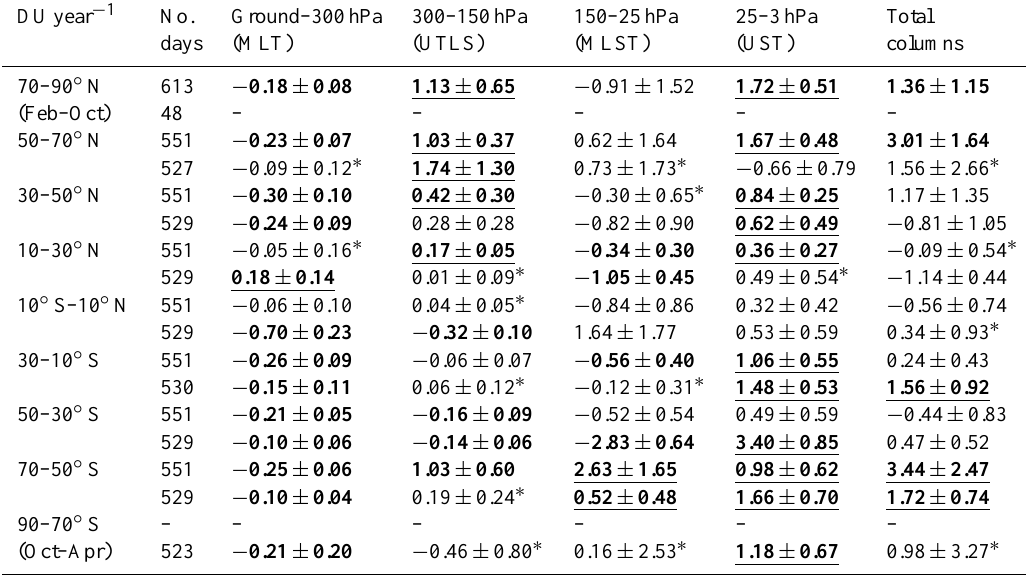
Table 3. Same as Table 2 but for seasonal O 3 trends and associated uncertainties based on daily medians during JJA (top values) and DJF (bottom values) periods. Values marked with a star (*) refer to trends which are rejected by the iterative backward elimination procedure a .